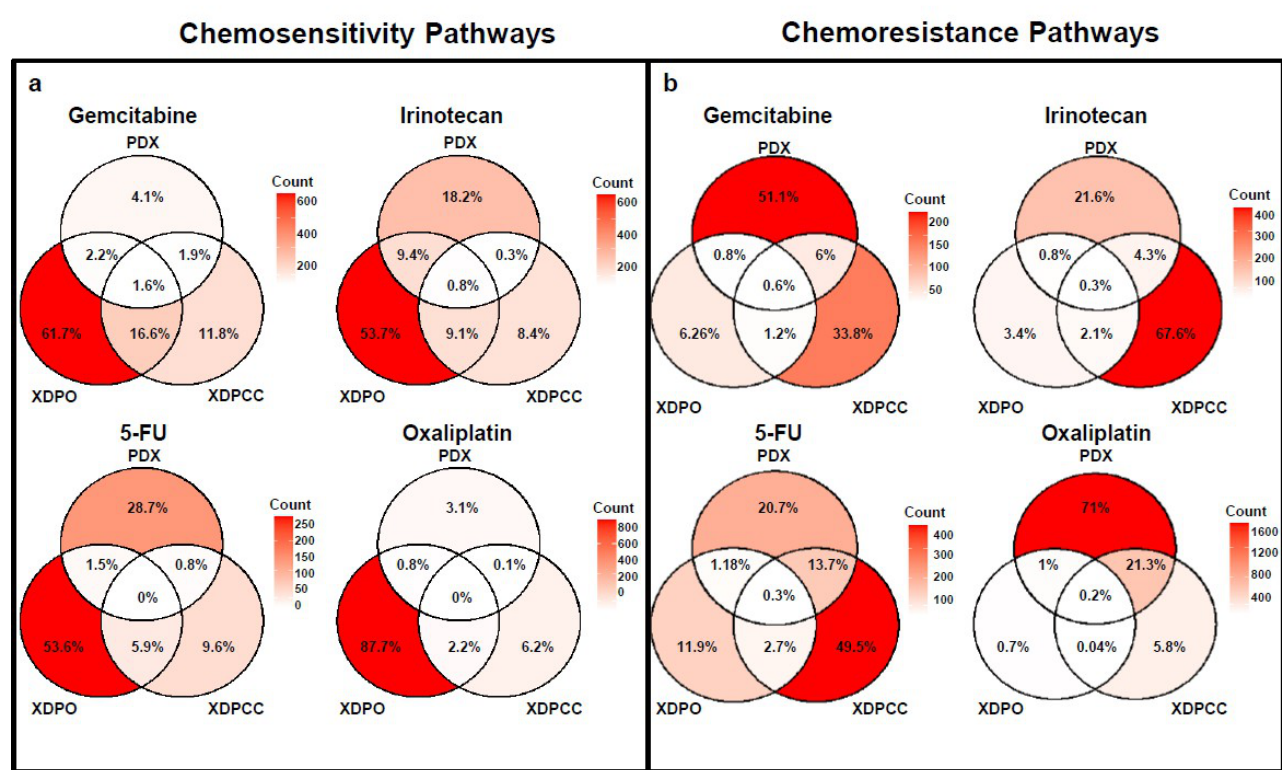
Figure 5. Molecular pathway analysis. Venn diagrams of all molecular pathways in common with all three models. ( a ) chemosensitivity associated pathways, ( b ) chemoresistance associated pathways. Count legend to the right depicts the number of pathways in common between models. The percentages are also included.